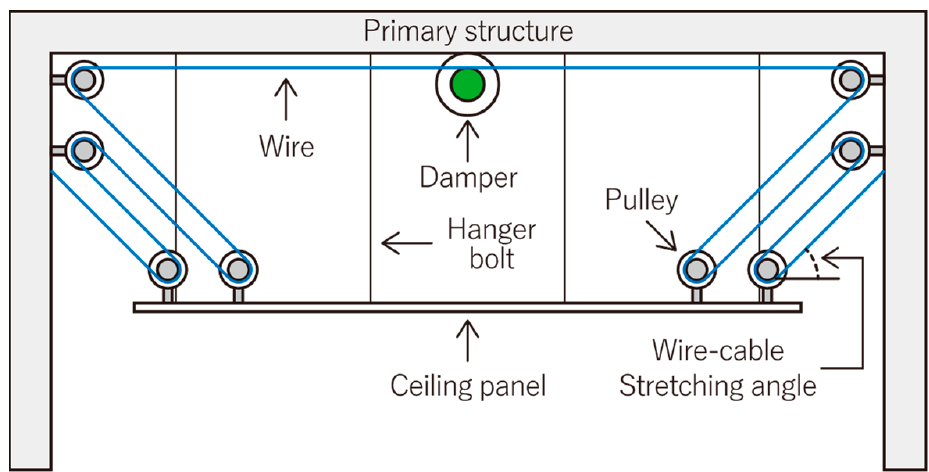
Figure 2. Concept schematic for the proposed pulley–damper ceiling system (PDCS).